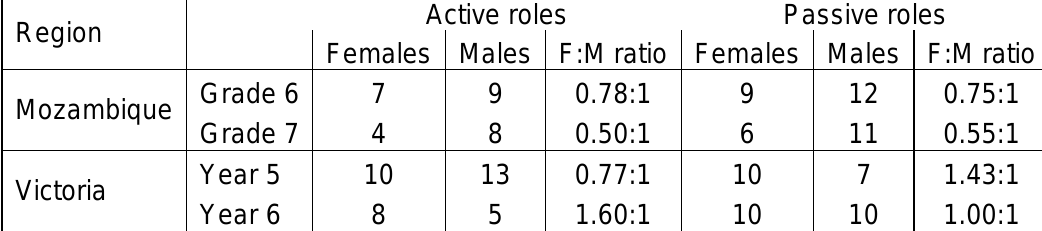
Table 5. Distribution of active and passive roles between females and